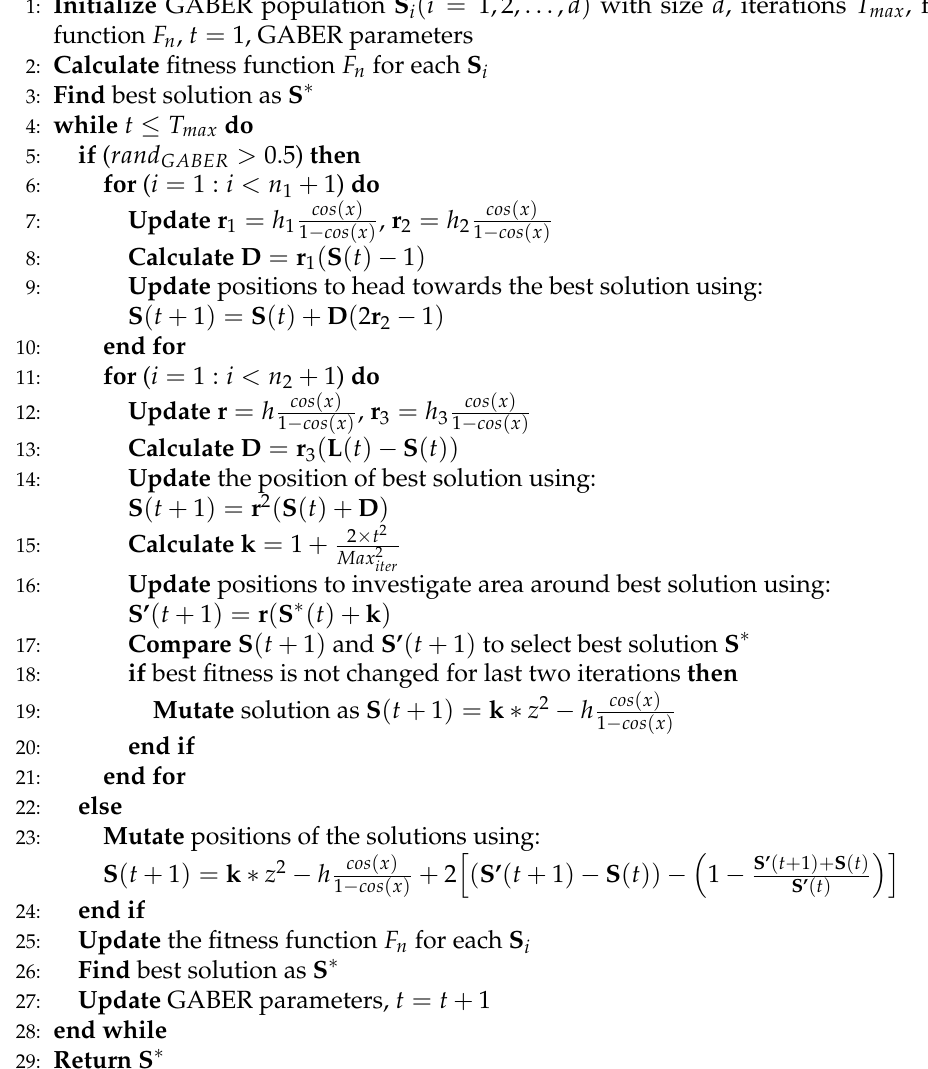
Algorithm 1 : The proposed GABER